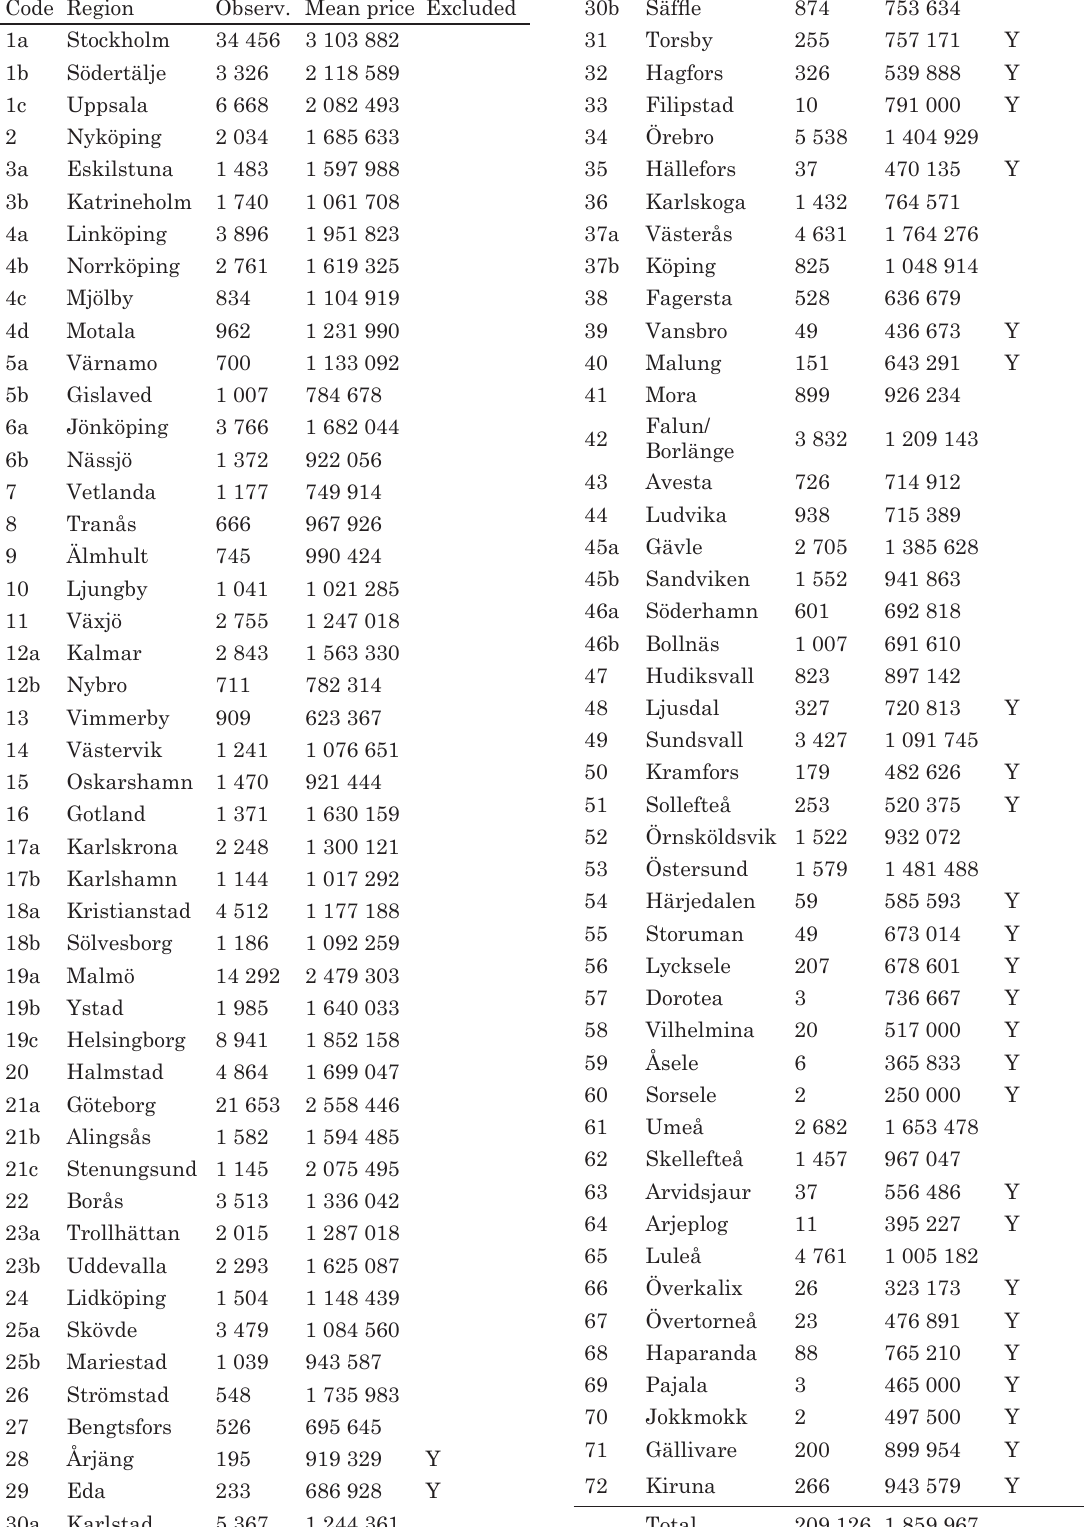
Table 9. Descriptive statistics concerning all labor markets (see Figure